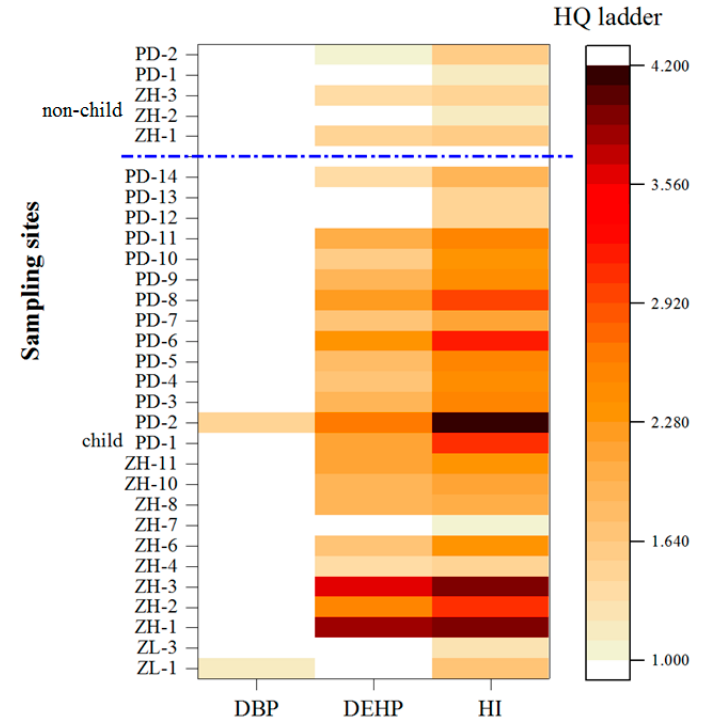
Figure 5. Heatmap of HQ values of all samples collected from the three study areas. Letters are abbreviations of study area; and numbers after the dash are the sequences of sampling sites.